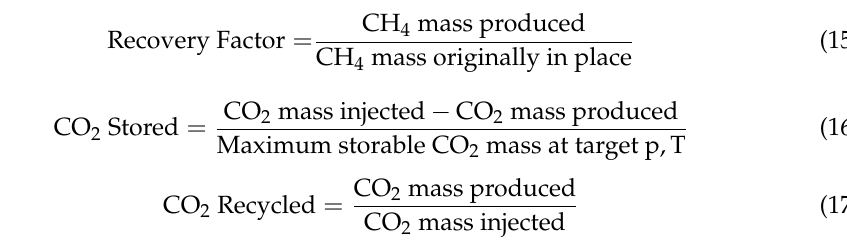
Figure 2. View of the 3D reservoir sector showing the permeability distribution and placement of the wells.